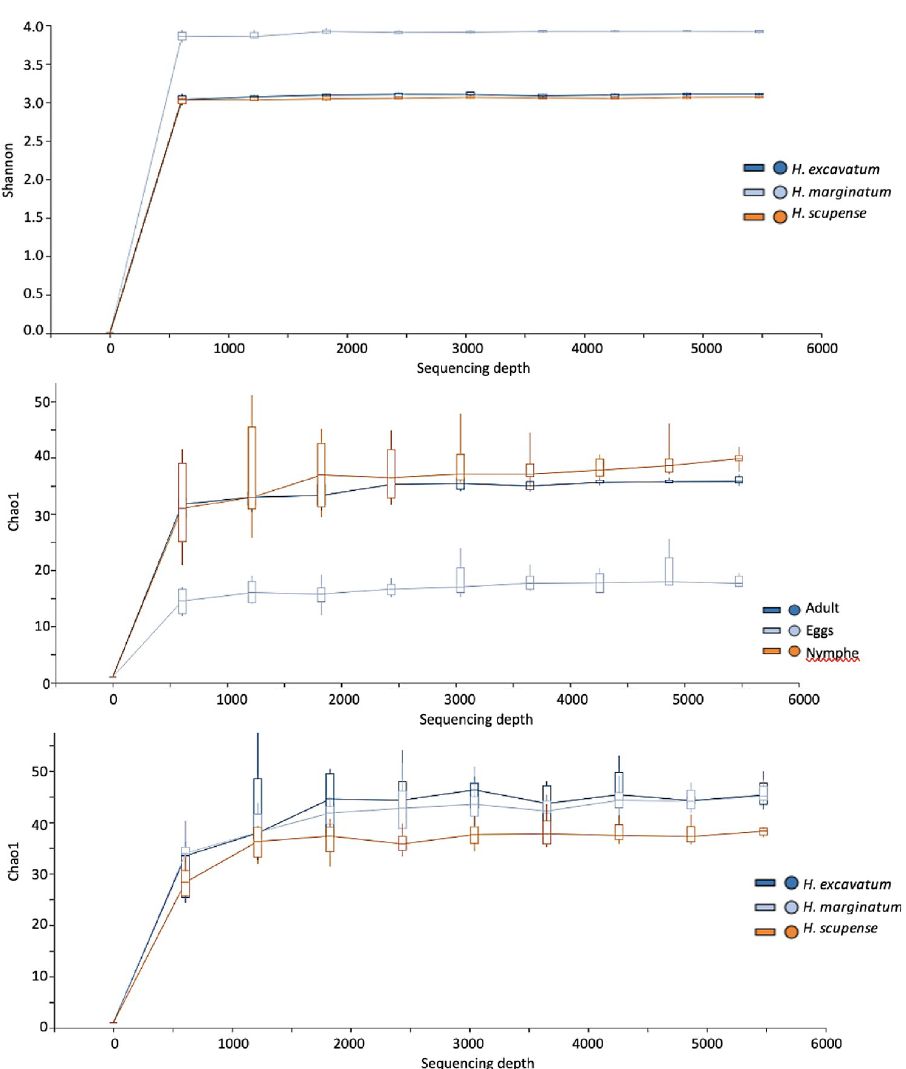
Fig 3. Alpha diversity and richness parameters of Hyalomma scupense microbiota. a: Shannon alpha diversity between species; c: Chao alpha diversity between species; b: Chao alpha diversity between life stages.